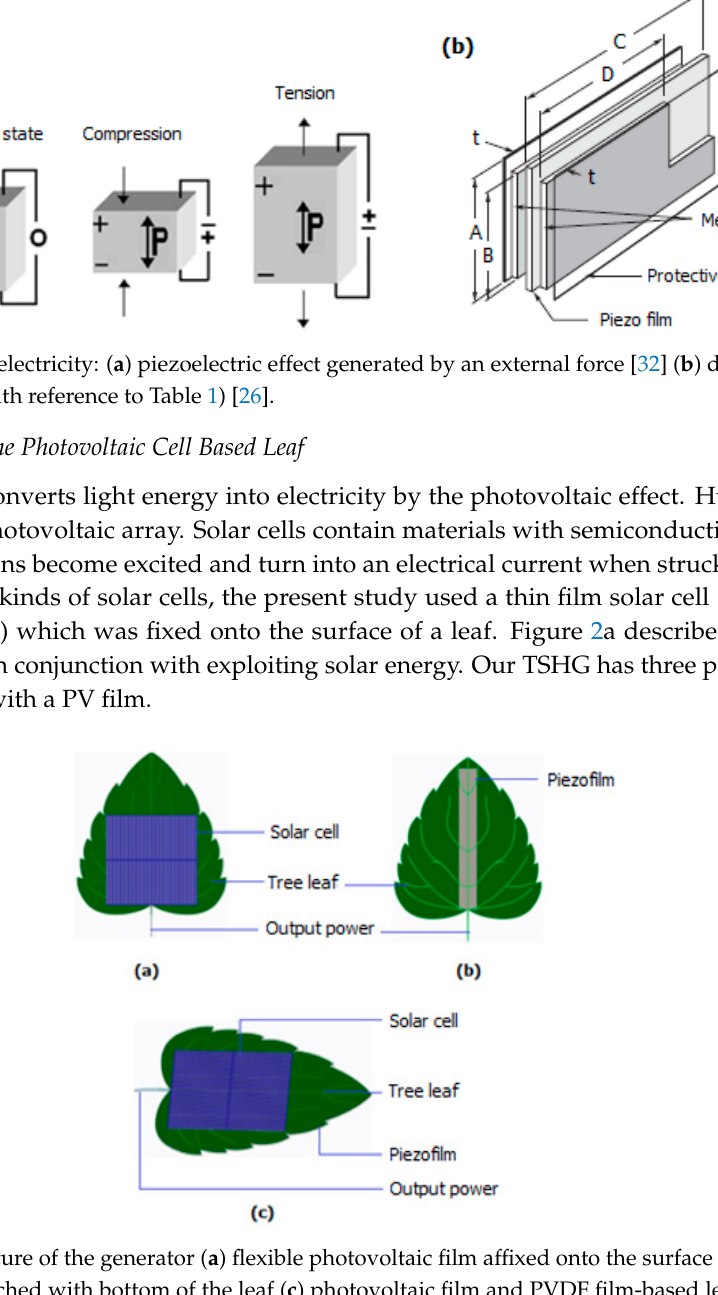
Figure 2. Structure of the generator ( a ) flexible photovoltaic film affixed onto the surface of a leaf ( b ) a PVDF film attached with bottom of the leaf ( c ) photovoltaic film and PVDF film-based leaf.